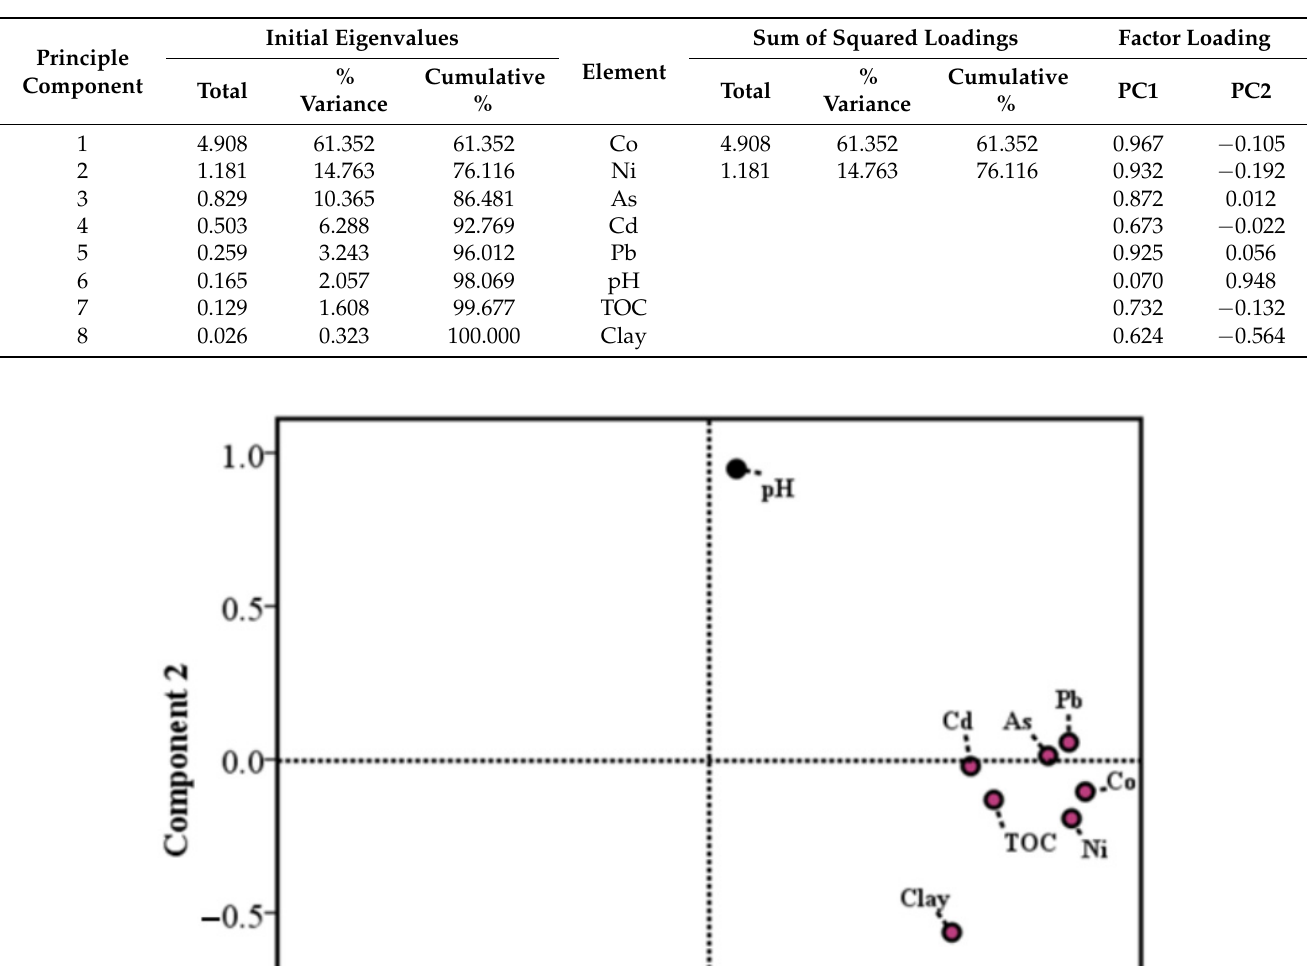
Table 4. Variances and rotated component matrices of heavy metals and physicochemical parameters in sediments.